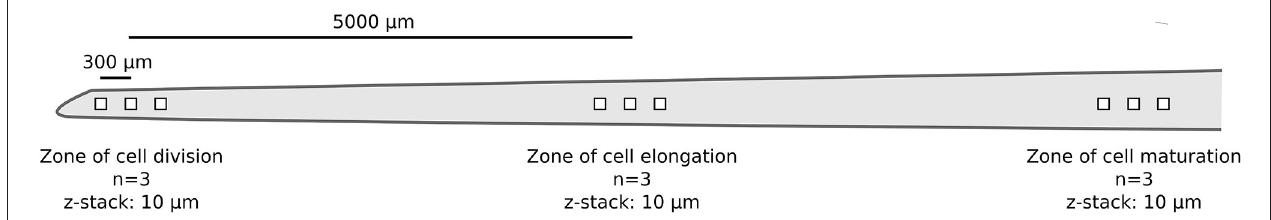
FIGURE 1 | Schematic representation showing the main parameters of microscopic image acquisition (true-to-scale) per replicate root ( n = 3). Distances between the individual z-stacks (300 µ m) and root regions (5,000 µ m) are indicated by bars.